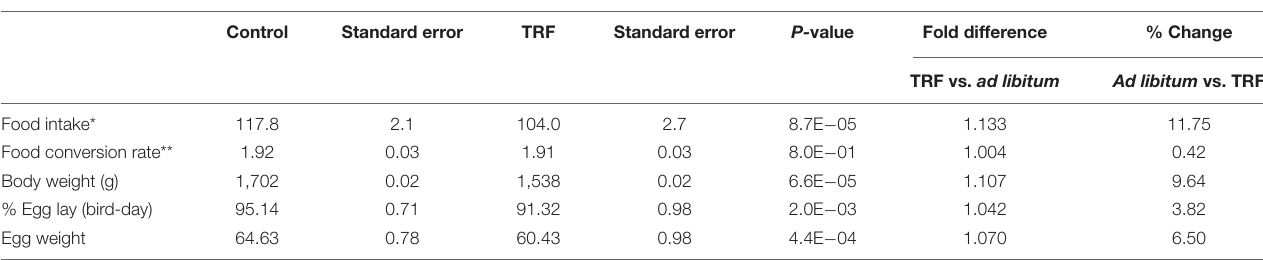
FIGURE 1 | Effect of the TRF treatment on food intake and performance. (A) Feed intake N = 10. (B) Body weight. (C) Egg weight. (D) Laying efficiency, calculated per actual living bird (bird-day; 100% = 1 egg per bird per day). ∗ , ∗∗ , and ∗∗∗ represent P -values < 0.05, 0.01, and 0.001, respectively, obtained from T -test. Annual statistics are presented in Table 3 . (E) Laying efficiency similar to (D) but calculated per the original number of birds at the beginning of the experiment (hen-housed). Statistical analysis for (E) is shown in Table 4 . N = 80 for each treatment (B–E) . Black and red lines represent the control and TRF groups, respectively. TABLE 3 | Summary of the responses to TRF treatment (annual